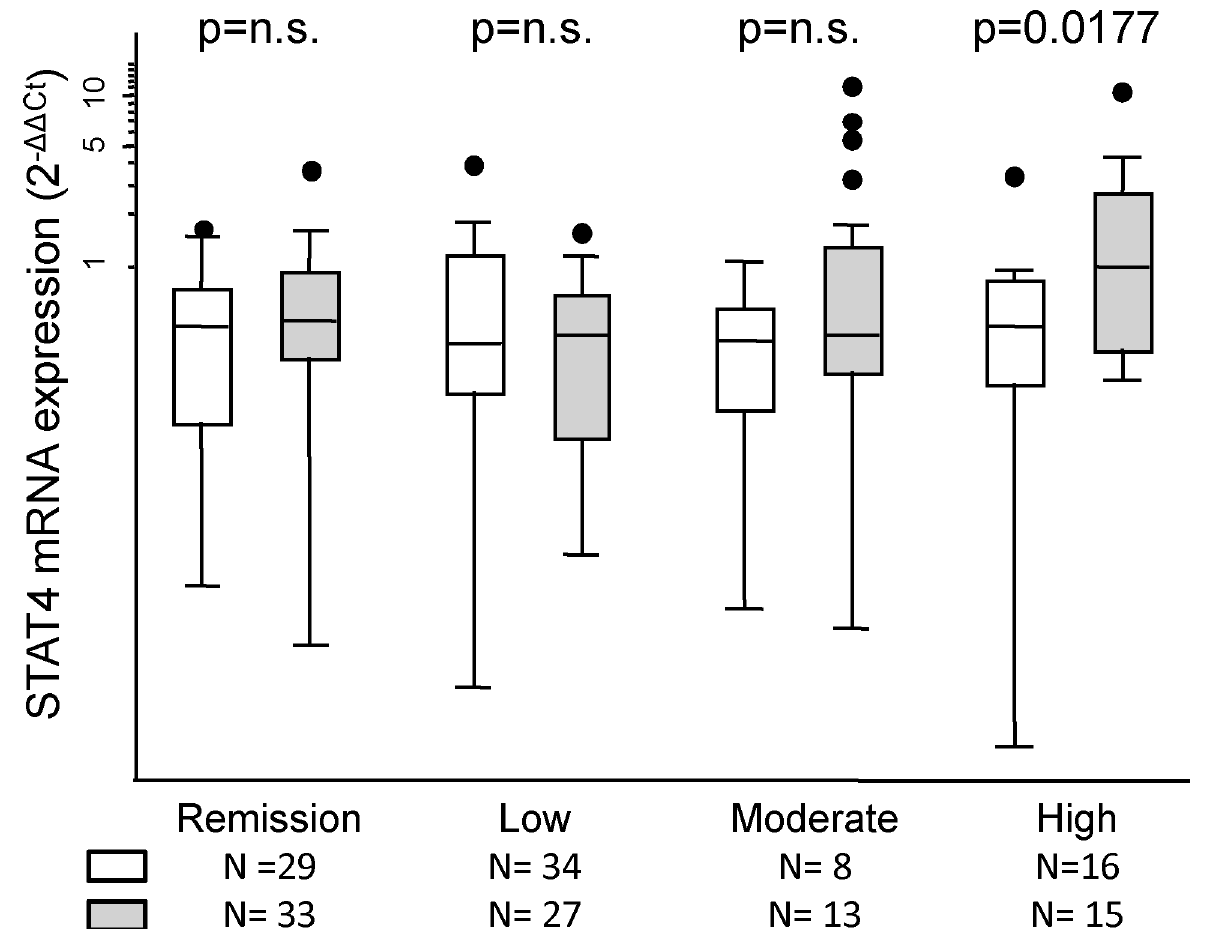
Fig 2. STAT4 mRNA is increased in patients with active early arthritis carrying the T allele of rs7574865. Expression levels of STAT4 mRNA according to the genotype of rs7574865, homozygote GG (white boxes) versus presence of the T allele (gray boxes), and disease activity level based on DAS28. Data are presented as the interquartile range (p75 upper edge, p25 lower edge, p50 midline), p95 (line above the box), and p5 (line below the box) of relative mRNA STAT4 expression (2 - ΔΔ Ct ). Dots represent the outliers. Significance level was determined through the Mann-Withney test. Due to multiple comparisons, statistical significance was considered p < 0.0125 (Bonferroni